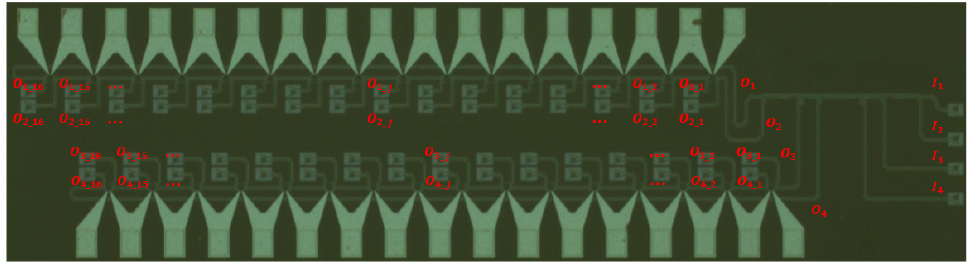
Figure 3. Microscopic image of the fabricated 64-channel hybrid WDM–MDM (de)multiplexer.